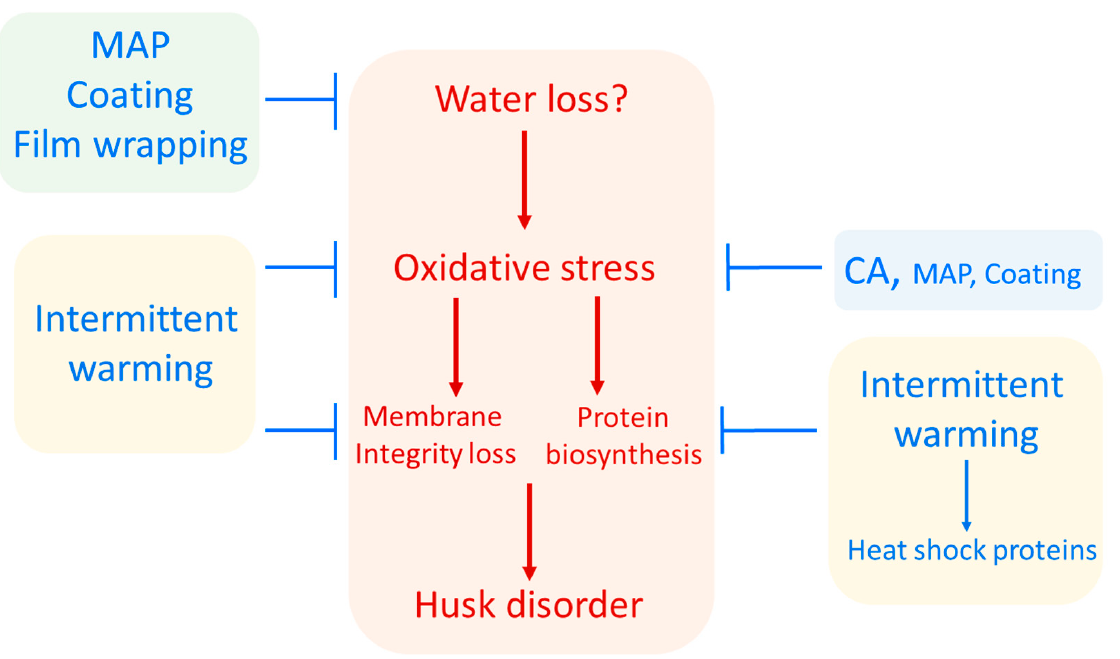
Figure 3. Hypothesis of pomegranate husk scald incidence during storage and the possible targets of postharvest treatments. Accordingly, MAP, coating and film wrapping systems would work mainly by preventing water loss, while CA would have a mode of action involving a decrease in oxidative stress by reducing the presence of oxygen. Furthermore, MAPs and coatings may also play in part this role of reducing oxidative stress. On the other hand, intermittent warming may exert its effects by inducing heat shock-like proteins in a hierarchical stress response model or alternatively by reducing oxidative stress and preserving membrane fluidity.